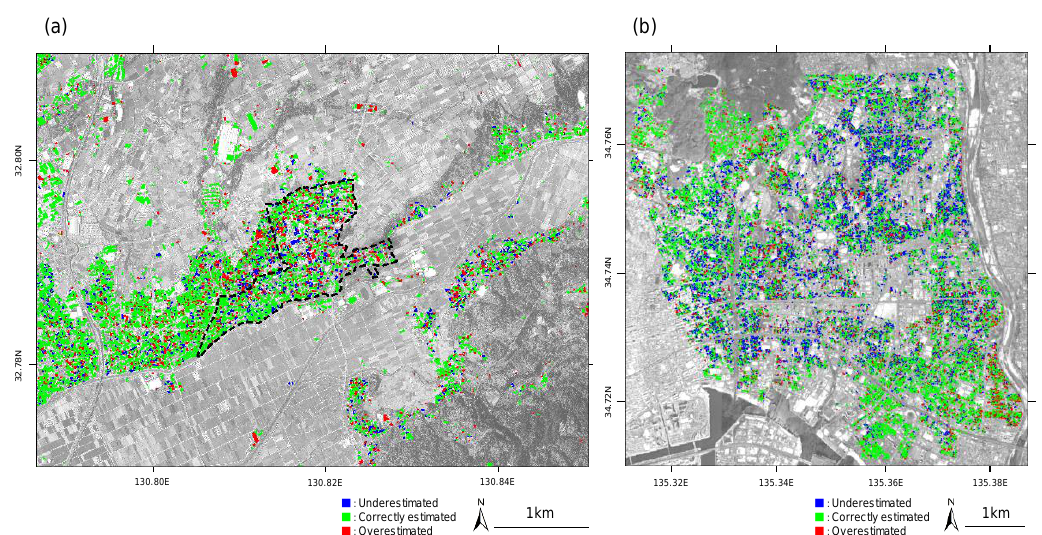
Figure 10. (a) 2016 Kumamoto earthquake; (b) 1995 Kobe earthquake. Distributions of the difference of damage classes between the estimation and the inventory. The green regions indicate the buildings correctly classified by the CNN model. The blue and red regions represent the under- and overestimated areas by the CNN model, respectively.